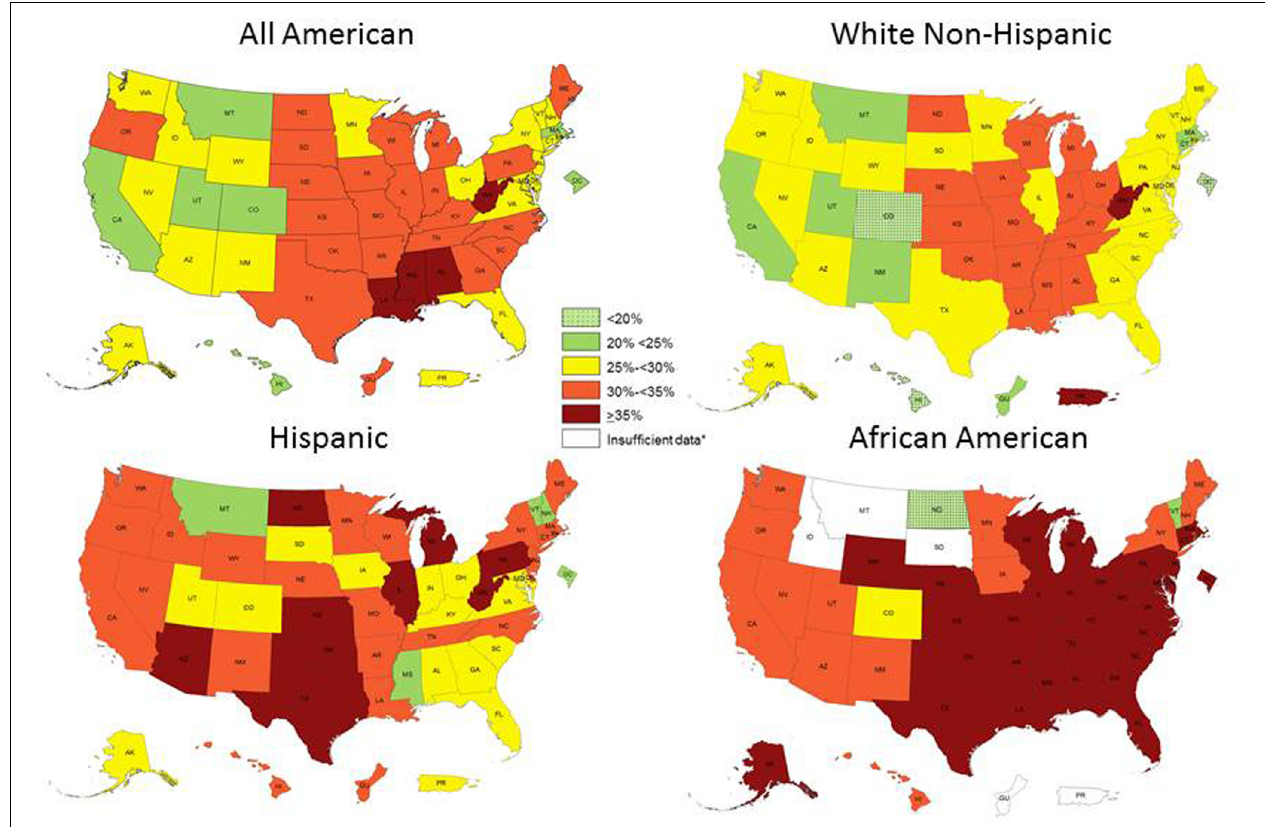
FIGURE 4 | Obesity prevalence according to ethnicity in the US in 2015. Modified from reference 35.